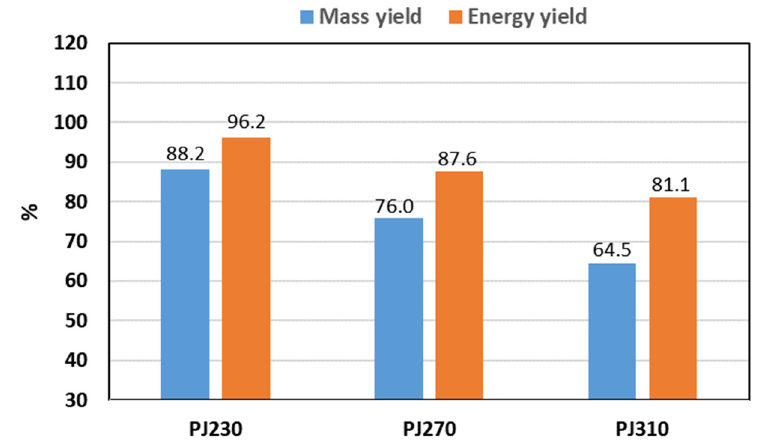
Figure 5. Mass and energy yields for the torrefaction the 203, 270, and 310 °C.